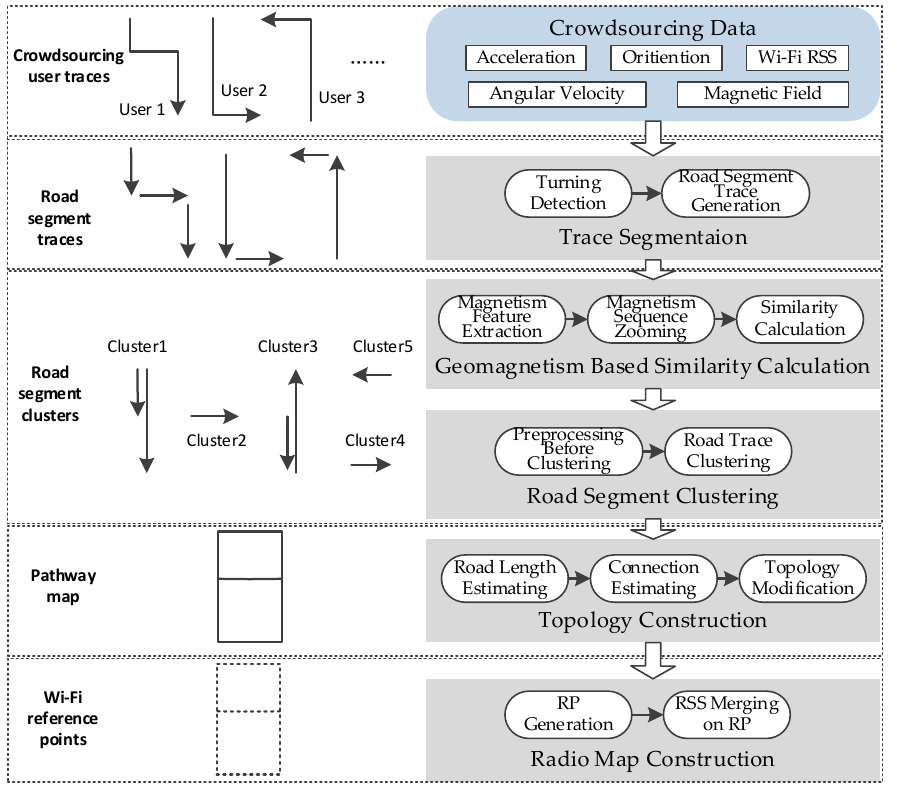
Figure 8. Overview of the geomagnetism-aided indoor Wi-Fi radio map construction method via smartphone crowdsourcing.